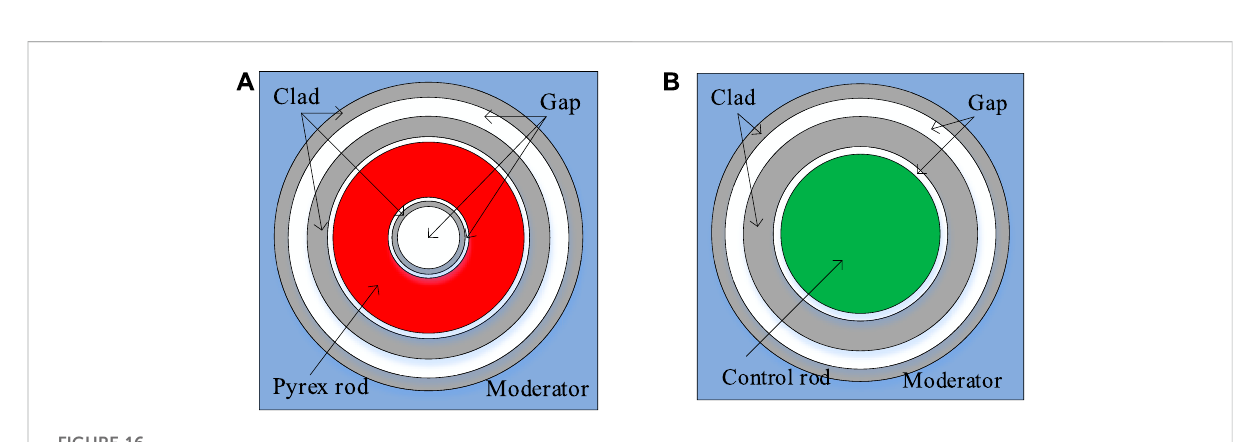
Figure 16. The strong absorber would dramatically in fl uence the neutron fl ux and raise challenges to the resonance calculation. In this section, VERA 2F, 2G, and 2H